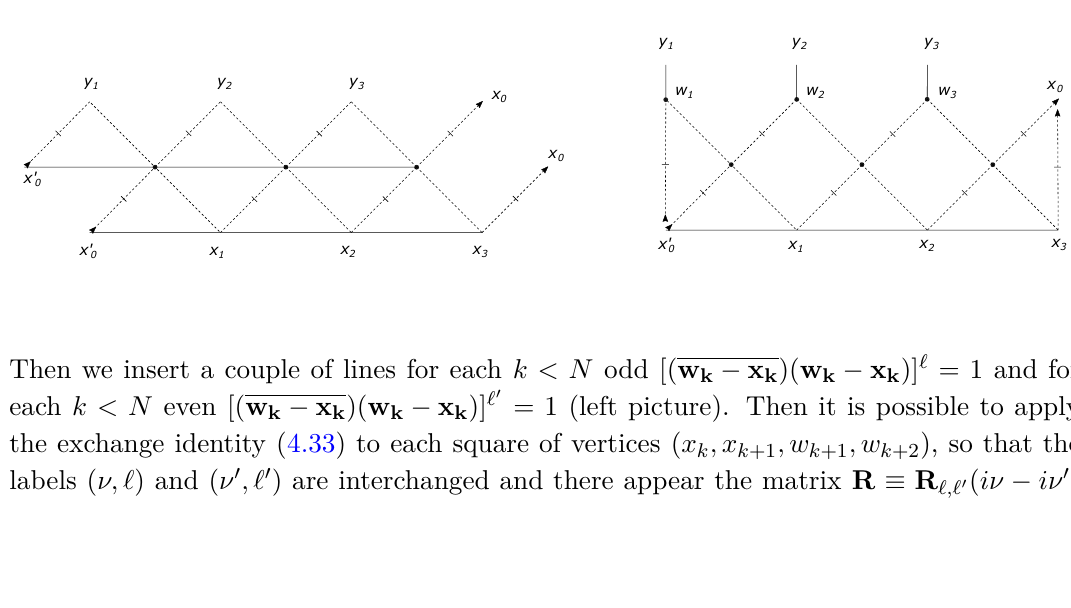
ˇ ( x | y ) for λ = − i . The solid lines Q (3) 0 , 1 ) 2 , the dashed lines stand for ( σ µ ( x − y ) ) / (( x − y ) 2 ) 2 while k − y k µ ) / (( x − y ) 2 ) 2 . The arrows denote the order of the µ